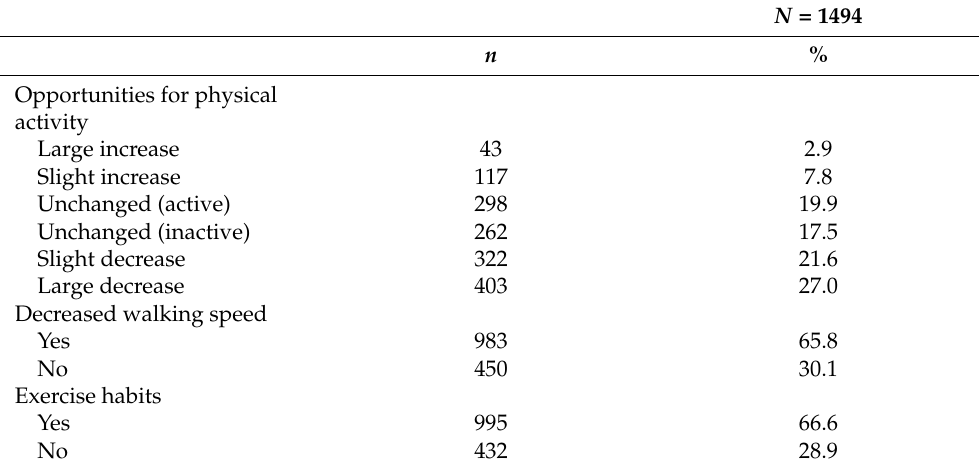
Table 2. Prevalence rates of physical